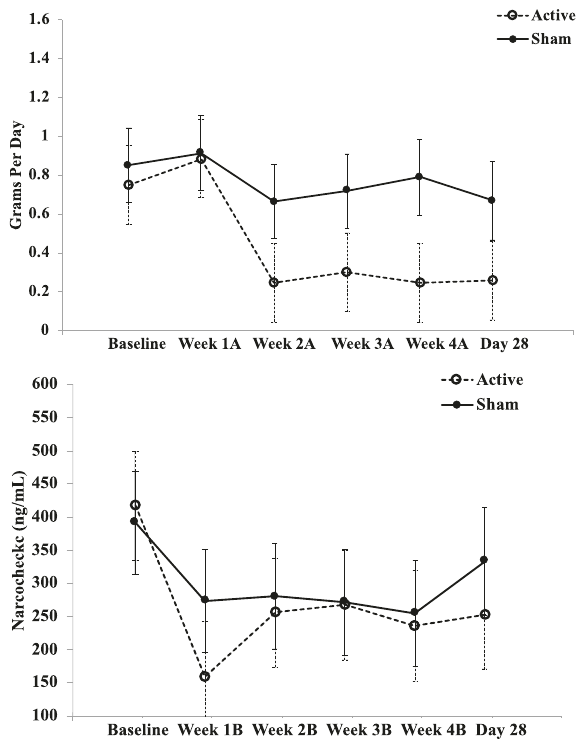
Fig. 2 Interaction plots of cannabis use over time between active and sham treatment. Interaction plots of cannabis use with values given as estimated marginal means (EMM) ± standard error are used as error bars. EMM were used in interaction plots as a function to visualize the model at the group level (active and sham, each time point), not at the participant or data point level.